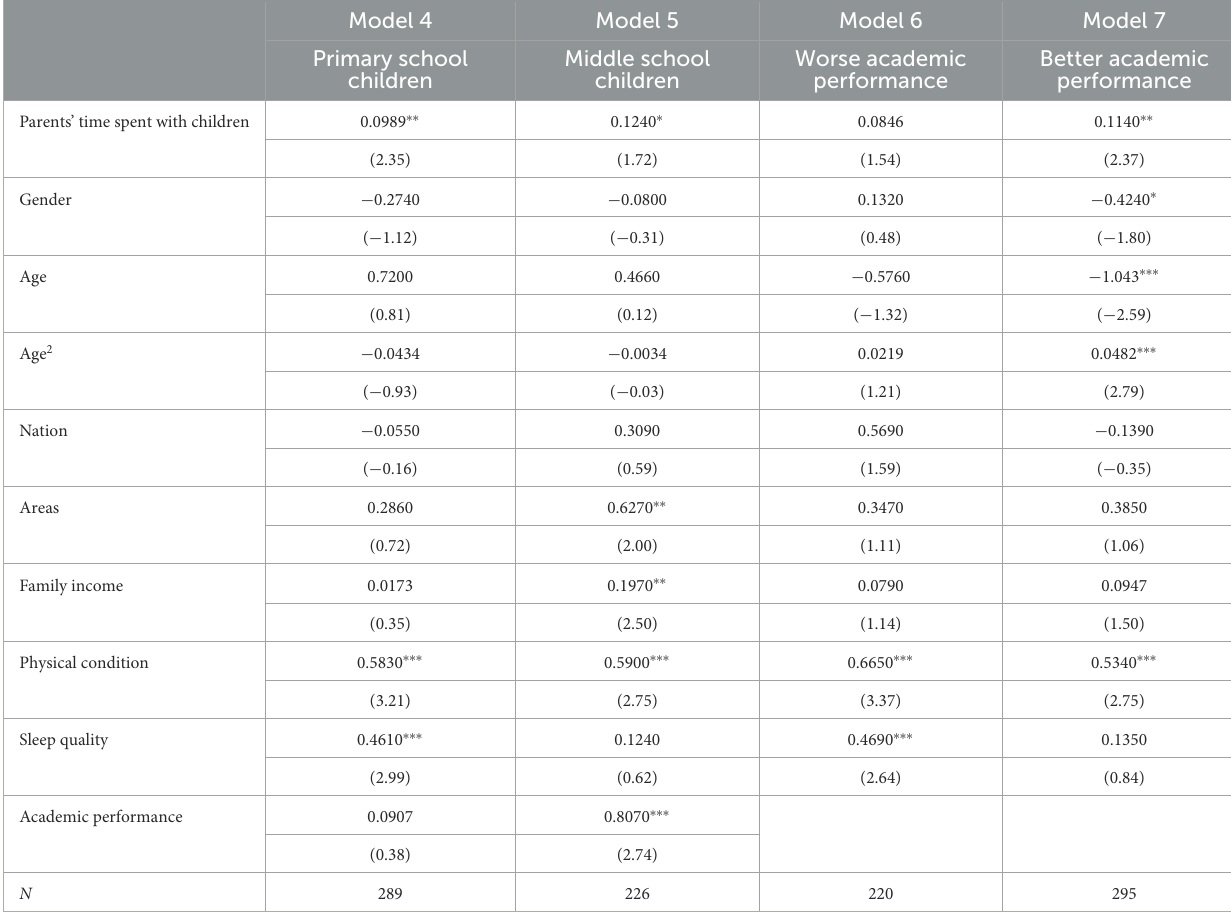
TABLE 7 Heterogeneity regression results of time spent with children on children’s